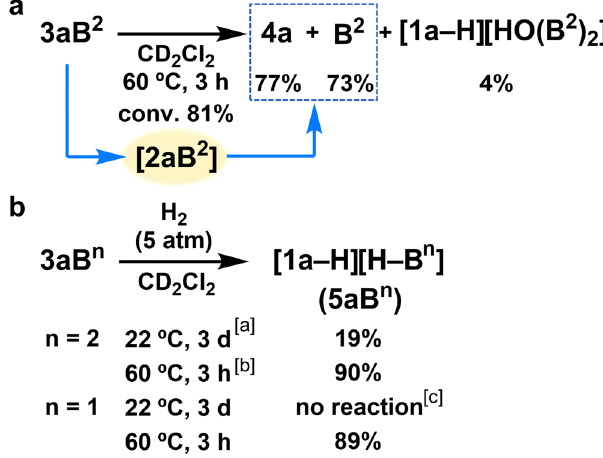
Fig. 3 Reactivity of carbene ‒ borane adducts 3aB n ( n = 1, 2). a Thermolysis of 3aB 2 monitored via NMR spectroscopy. Product yields were calculated based on 31 P and 19 F NMR analyses. b Reaction between 3aB n and H 2 . Product yields were calculated based on 19 F and 31 P analysis. a [ 1a ‒ H][HO( B 2 ) 2 ] and 1a were also observed in 8% and 6% yield, respectively. b [ 1a ‒ H][HO( B 2 ) c Results obtained 2 ] was also observed in 7% yield.